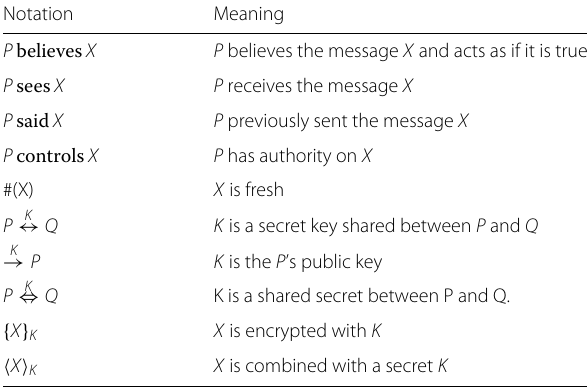
Table 2 Notations of BAN logic